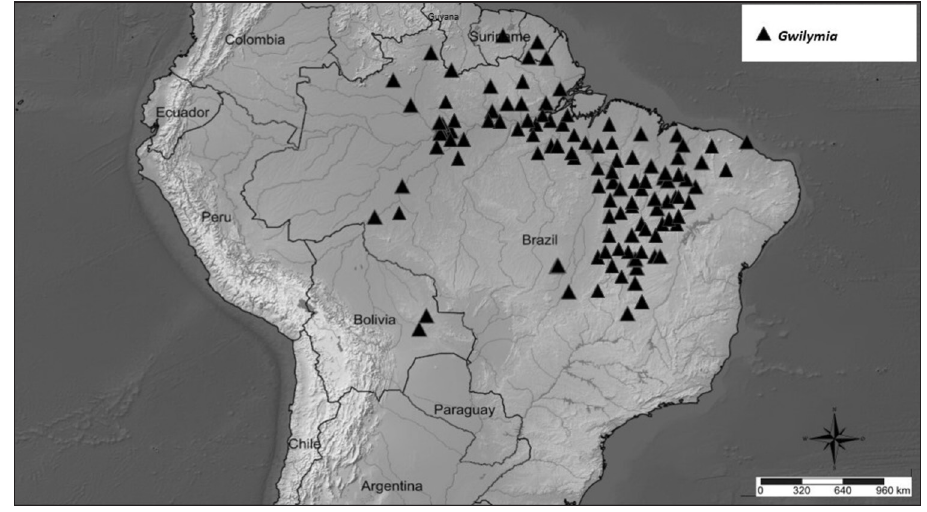
Figure 8. Distribution of Gwilymia